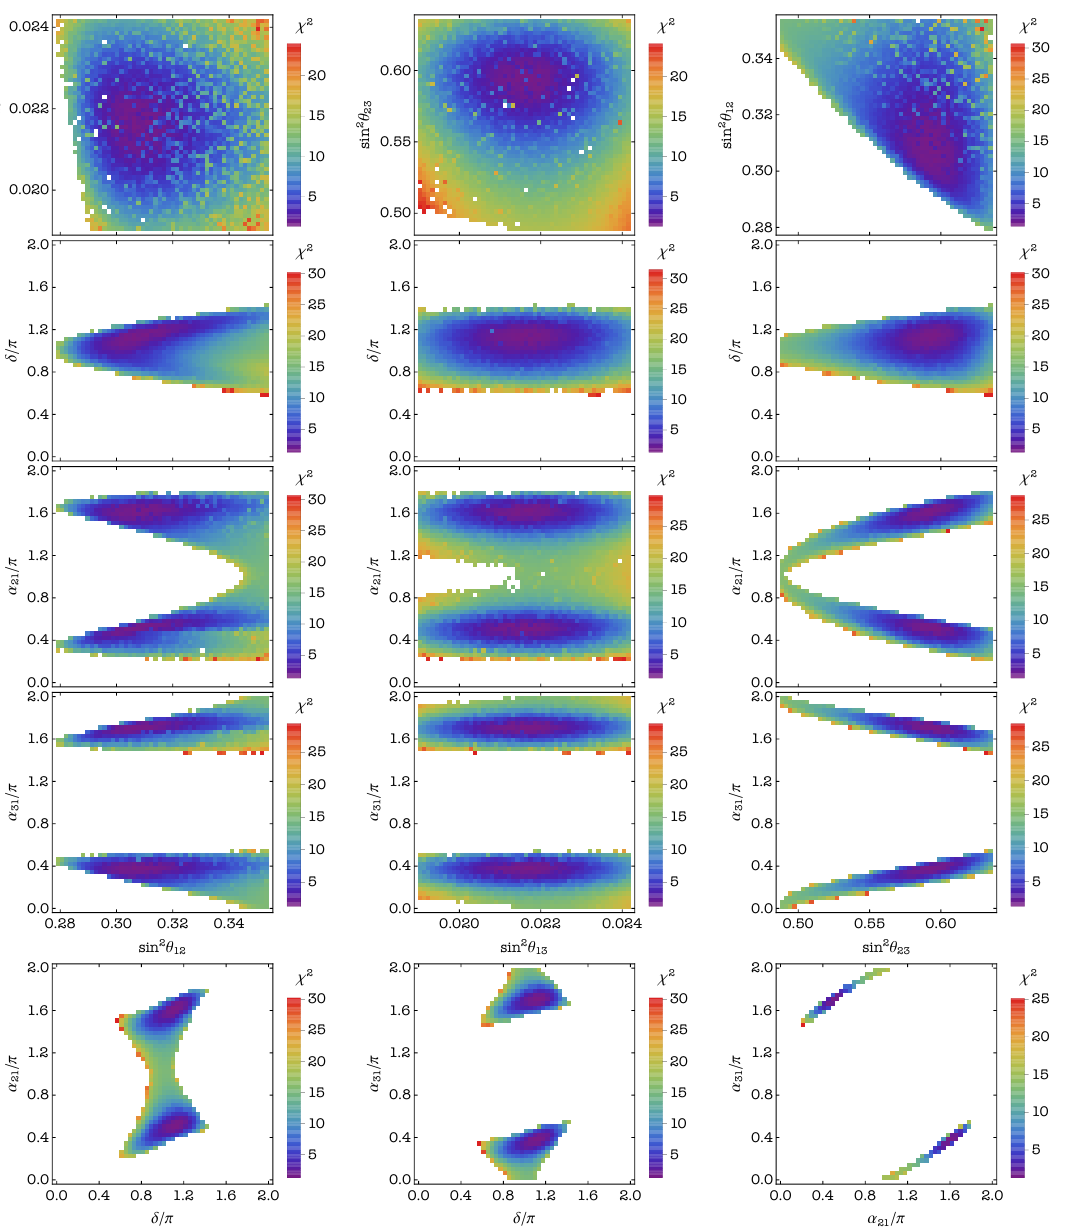
Figure 11 . Correlations between the neutrino mixing parameters in case D3. The values of all the three mixing angles are required to lie in their respective 3 (cid:27) ranges. Colour represents values of (cid:31) 2 for the IO neutrino mass spectrum.